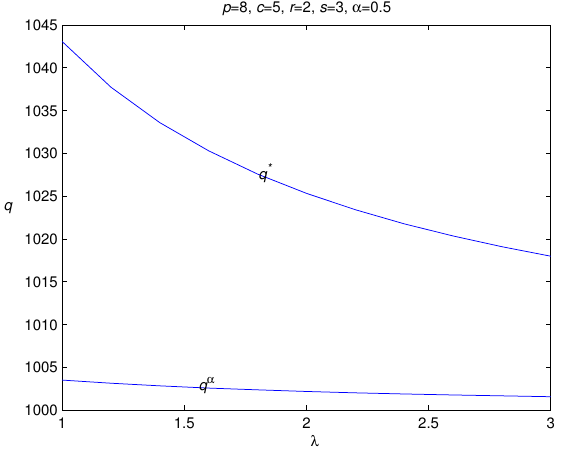
Figure 5. Optimal order quantities q ∗ and q α with different loss aversion coefficients λ